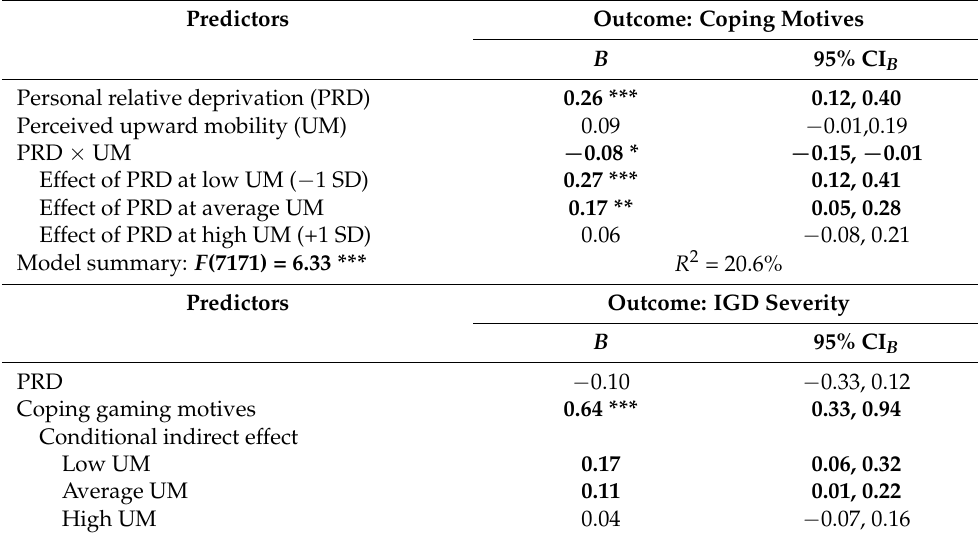
Table 5. Moderated mediation summary for Study